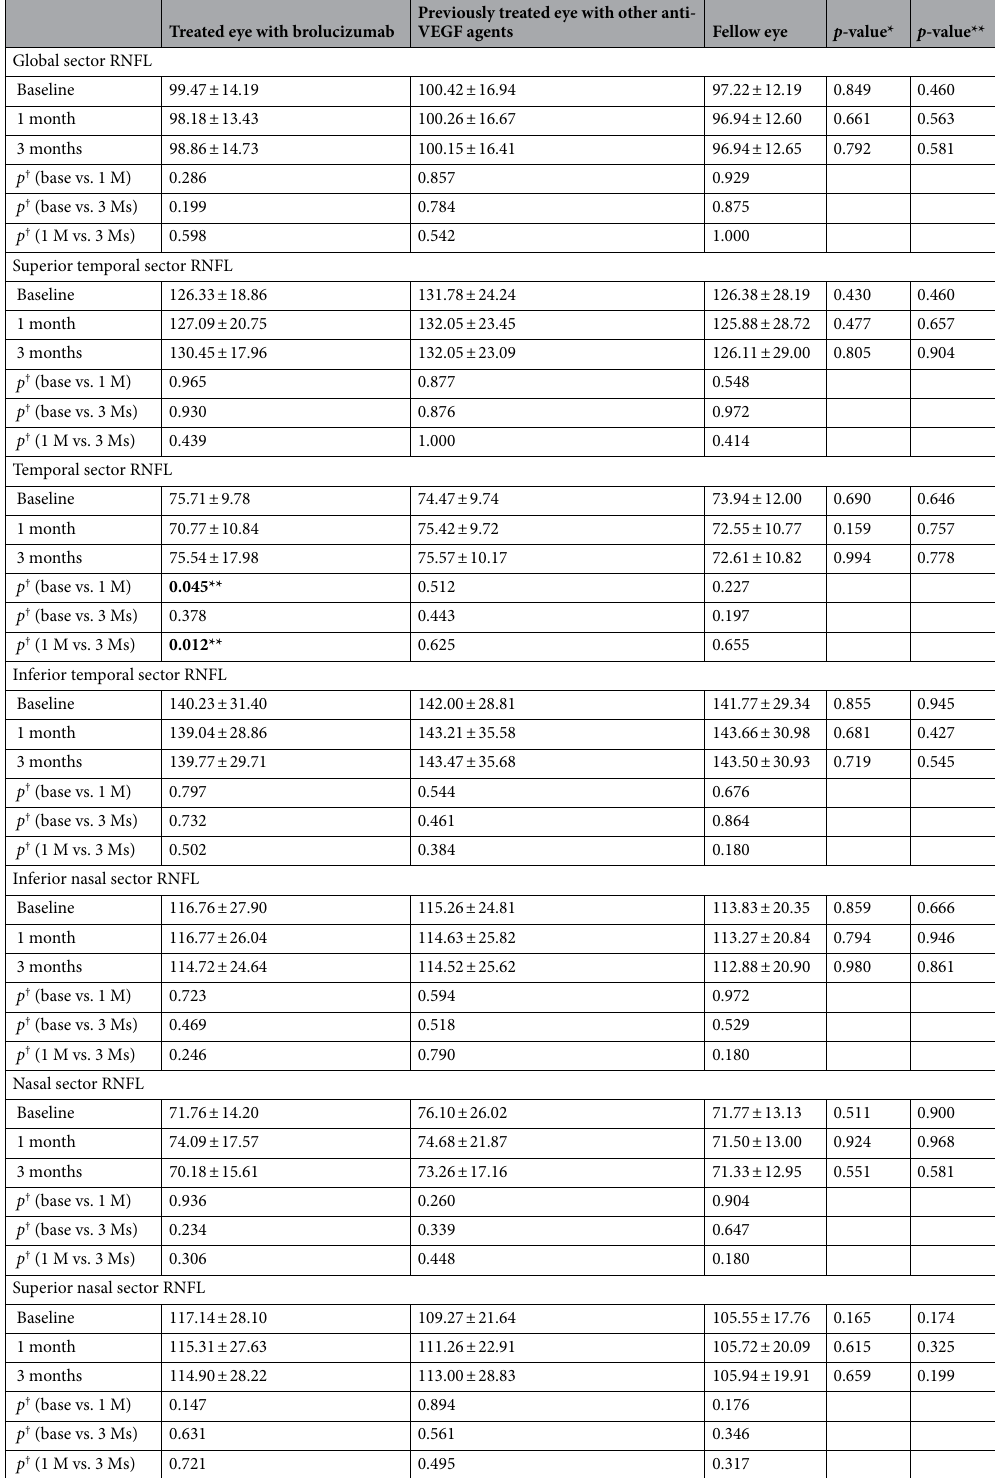
Table 2. Longitudinal changes of the retinal nerve fiber layer thickness (μm) in the group administered intravitreal brolucizumab injection and the untreated fellow eyes. The significant p -values are shown in [bold]. *Comparison between treated eyes with brolucizumab and previously treated eyes during the early phase with other anti-vascular endothelial growth factor agents (Mann–Whitney U -test). **Comparison between treated eyes with brolucizumab and untreated fellow eyes in each period (Mann–Whitney U -test). † Comparison between the baseline and follow-up visits for each value (Wilcoxon signed-rank test). RNFL, retinal nerve fiber layer; base, baseline; M,